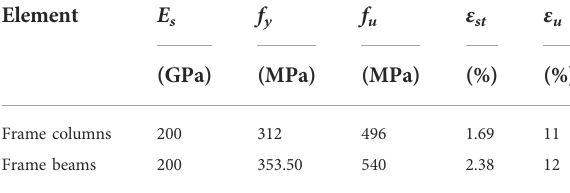
TABLE 2 Mechanical properties of steel members used in the FE- models. Element